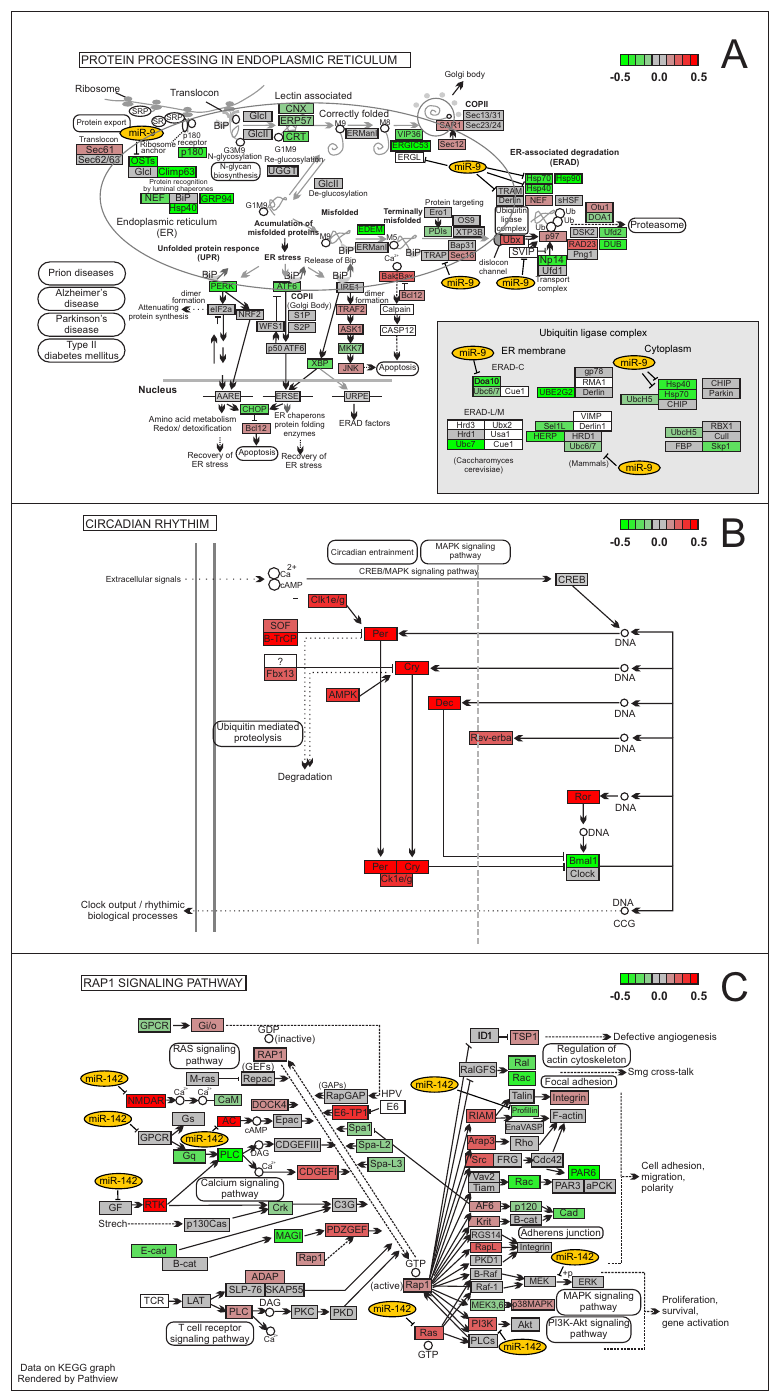
Figure 5. miRNA-responsive biological pathways and the presence or absence of interactions between its genes and the transfected miRNA. ( A ) predicted interactions among miR-9 (yellow ellipses) and the mRNAs of a biological pathway perturbed after miR-9 transfection; ( B ) miR-1 responsive biological pathway with no predicted interaction between miR-1 and its genes; ( C ) predicted interactions among miR-142 (yellow ellipses) and genes either up- or down-regulated after miR-142 transfection. Green rectangles represent down-regulated mRNAs. Red rectangles represent up-regulated mRNAs. Gray rectangles represent mRNAs with little-to-no fold change after miRNA